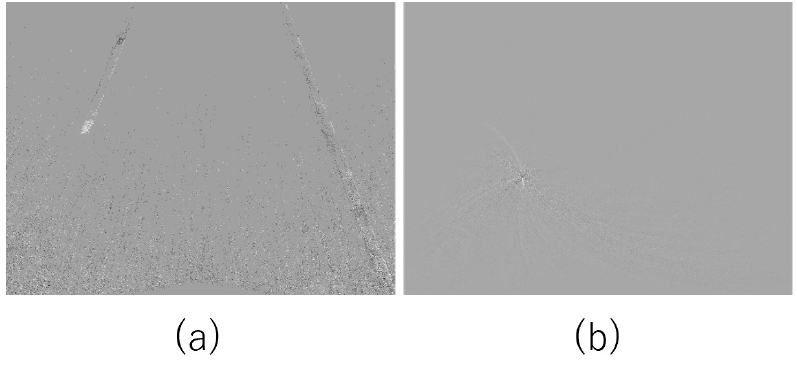
Figure 1. An example of failed estimation. ( a ) Events before estimation. ( b ) Events warped by the wrong estimation. The events have been warped onto the same